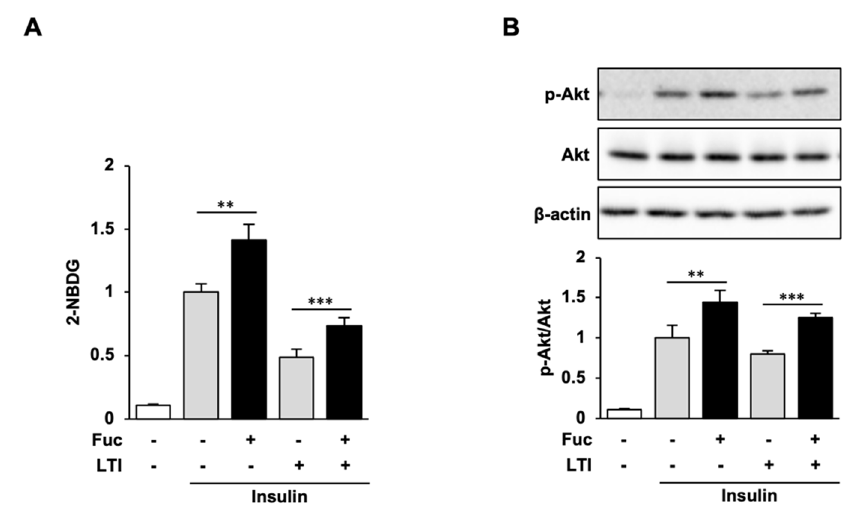
Figure 5. Effects of L-fucose (Fuc) on glucose uptake and Akt phosphorylation in insulin-resistant adipocytes. ( A , B ) Adipocytes pretreated with Fuc for 4 h were exposed to a combination of Fuc and LPS, TNF α , and IFN γ (LTI) for 20 h. To estimate the glucose uptake, adipocytes treated with Fuc and LTI were stimulated with 2-NBDG and insulin for 30 min. Data are presented as mean ± SD, ( n = 3) and statistical significance was calculated using Welch’s t -test (control vs. Fuc, CC vs. Fuc + CC, ** p < 0.01; *** p <